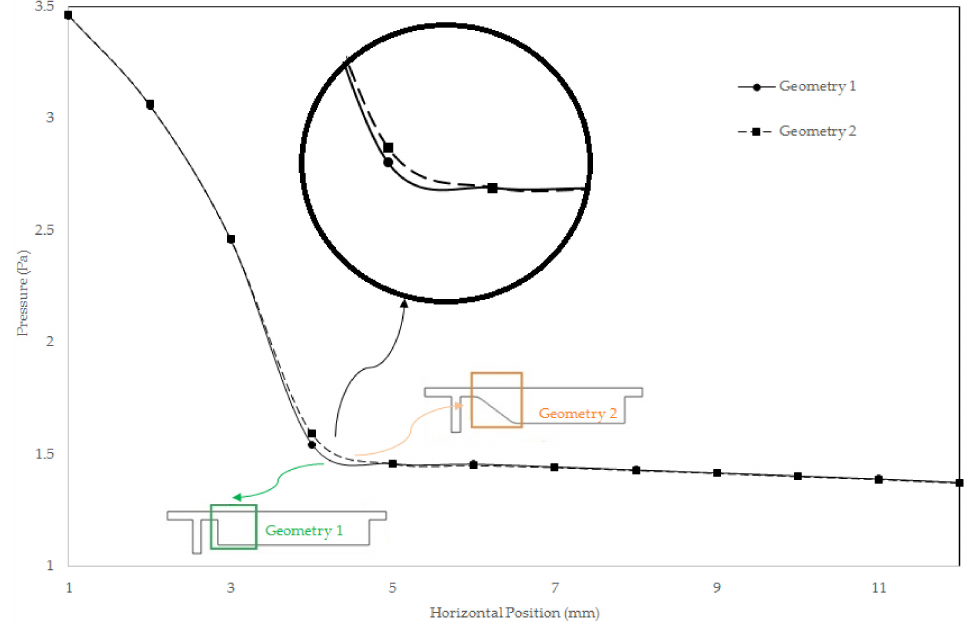
Figure 9. Pressure loss across the channel for two proposed geometry: in both geometries, the pressure decreases stream-wise and for Geometry 1 the loss is greater.